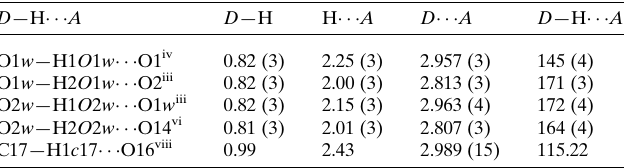
Table 2 Hydrogen-bond geometry (A˚ , (cid:5) ). The hydrogen bond O16 (cid:2)(cid:2)(cid:2) O4 vii is missing from this table because of the undetermined position of the bridging hydrogen atom.